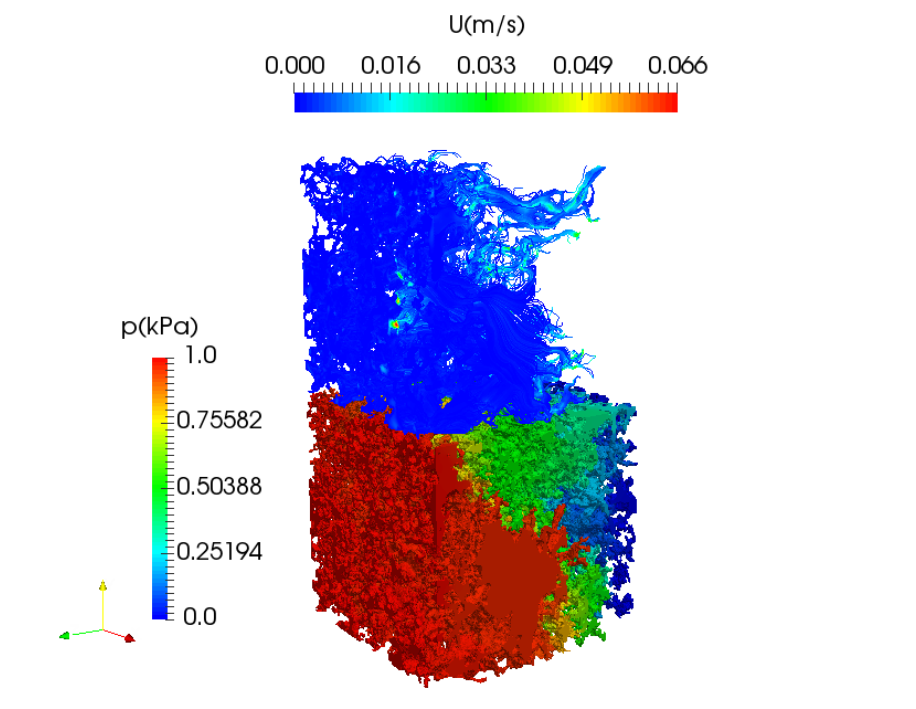
Figure 6. Simulated pressure field by FVM of the carbonate sample; streamlines, scaled by the velocity, are shown at the top of the pore structure for